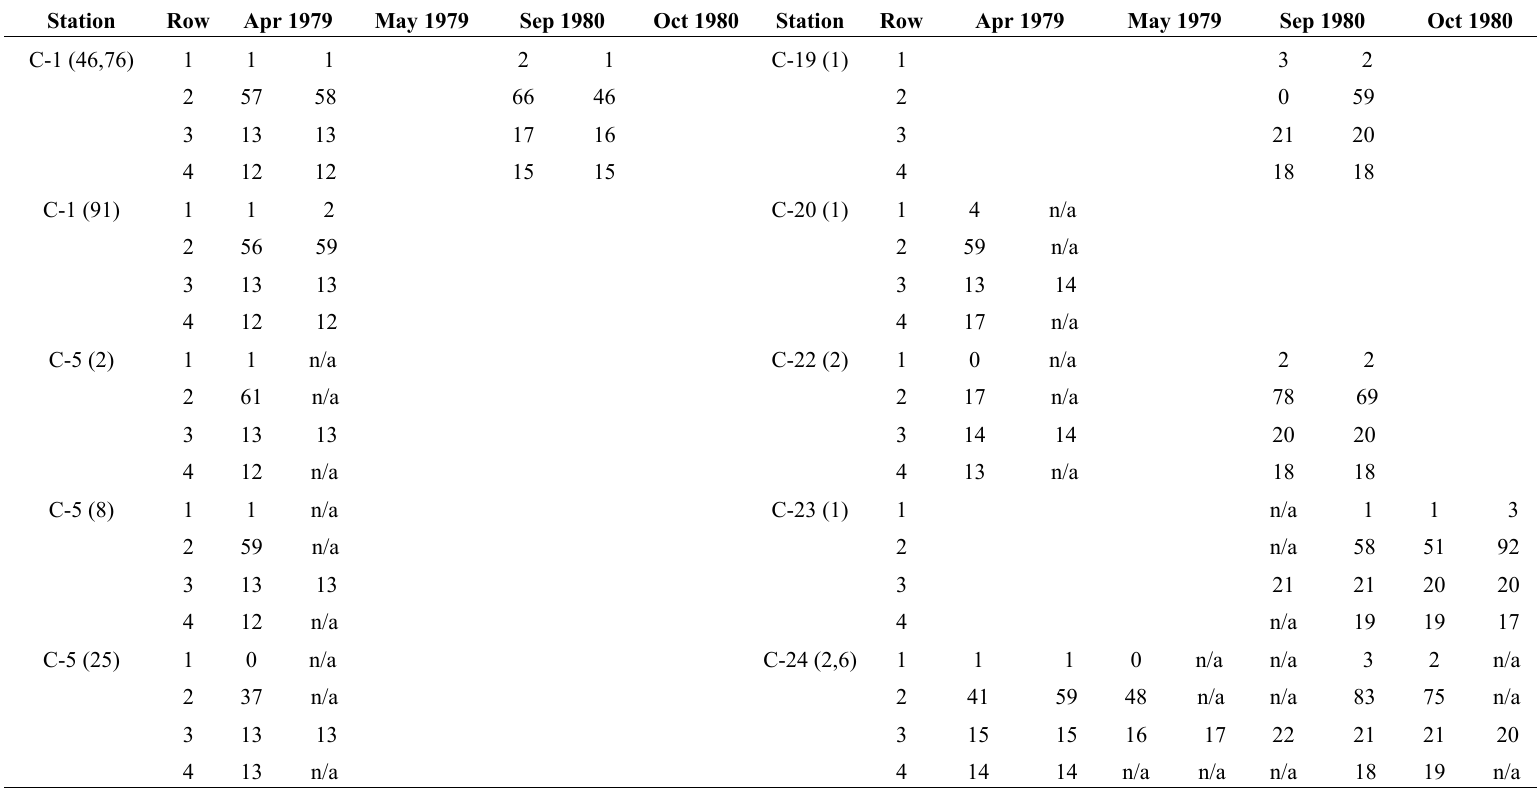
Table 12. Temperature Hindcast Validation: April 1979–October 1980. In each box month, the first column values correspond to the first 15 days of the month, with the second column of values denoting the remaining portion. Within each column: Row 1 corresponds to the RMSE in °C. Row 2 corresponds to the Willmott Relative Error in percent. Row 3 corresponds to the model mean in °C with Row 4 denoting the observed temperature mean in °C. Note n/a denotes not available due to incomplete observations. Along with the station id, the measurement location (in distance above the bottom in meters) is given in